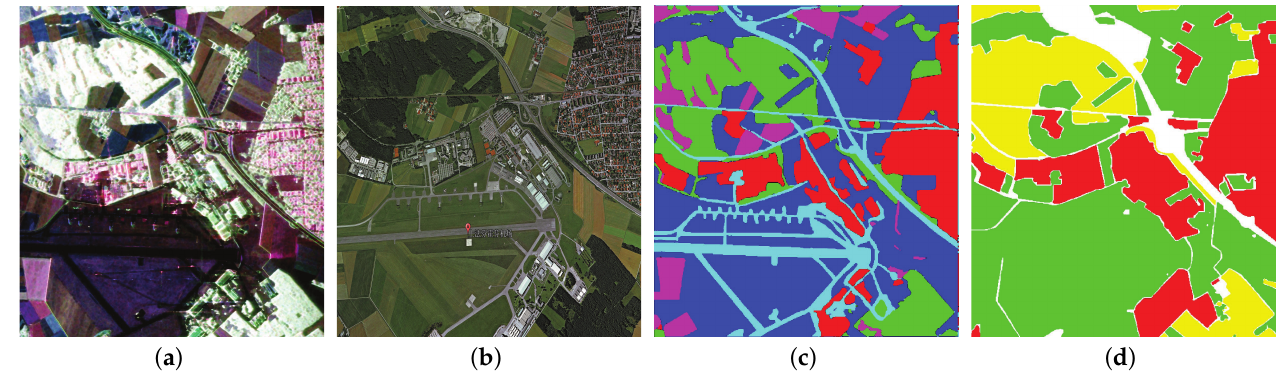
Figure 4. San Francisco data. ( a ) PauliRGB image. ( b ) Google Earth image. ( c ) Ground truth based on [29]. ( d ) Ground truth based on [30].